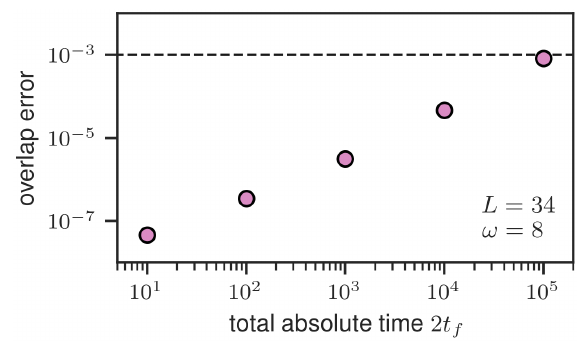
FIG. 7. The accumulation of error over time. The error on the wave function is quantified via the overlap of initial and final states in an “echo” procedure, where the wave function is evolved out to time t f and then the evolution is reversed using the time- reversed Floquet unitary U † in order to get back to time t = 0. F The quantity we show is | 1 − (cid:4) ψ( 0 ) | ψ (cid:15) ( 0 ) (cid:5)| , where | ψ (cid:15) ( 0 ) (cid:5) is the state obtained from evolving | ψ( 0 ) (cid:5) out to time t f and back. All simulations are run at ω = 8 and L = 34. The dashed black line is at the 0.1% error level, for